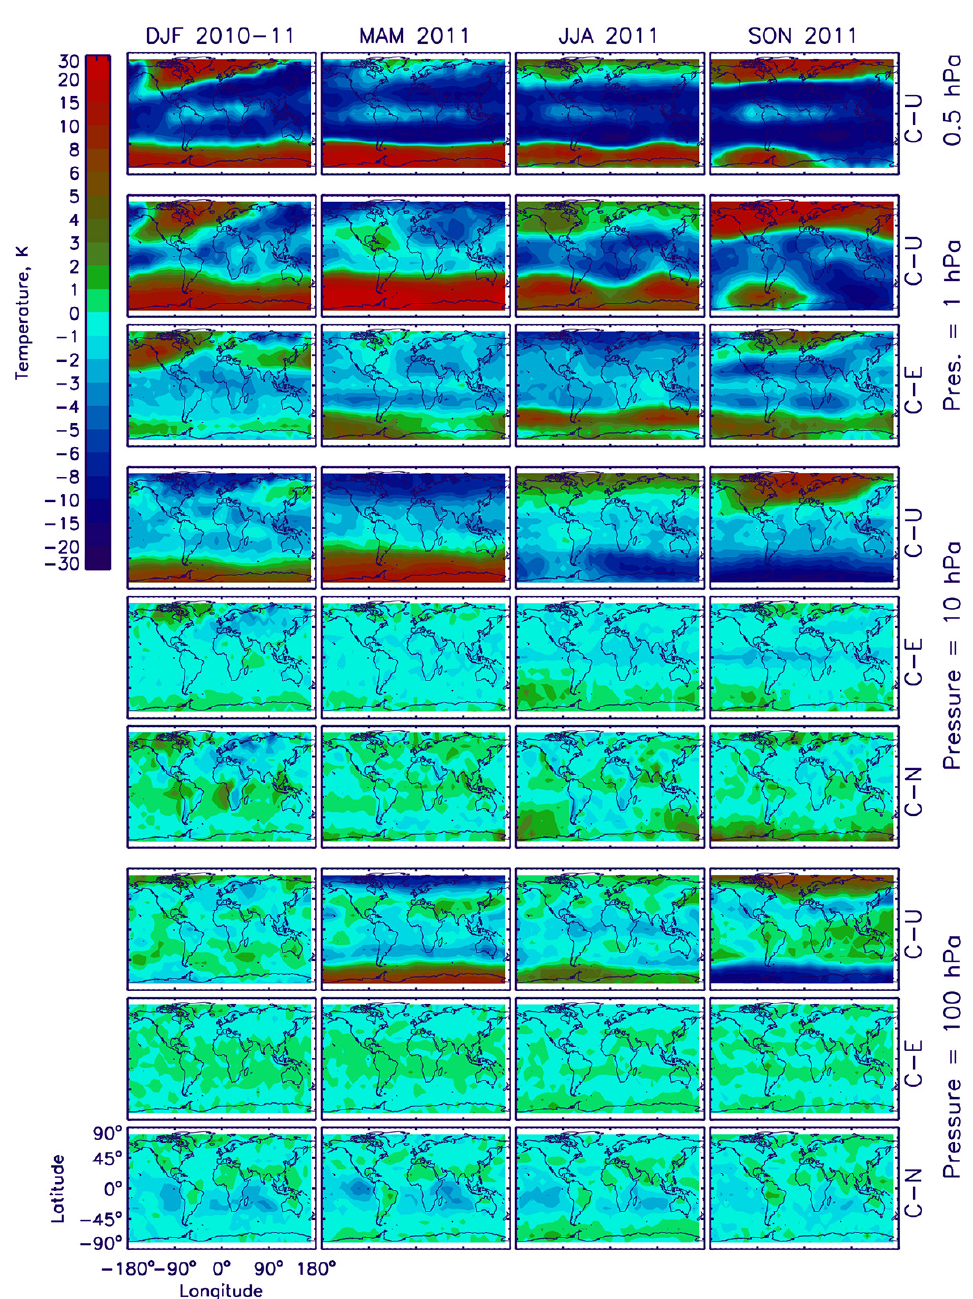
Fig. 5. Differences between the global seasonal means of COSMIC (C) and the reanalysis outputs – NCEP (N), ERA-Interim (E) and UKMO (U) – at 100hPa (rows 1 to 3 from bottom), 10hPa (rows 4 to 6 from bottom), 1hPa (rows 2 & 3 from above) and 0.5hPa (row 1 from above). Observe the nonlinearity in the colour